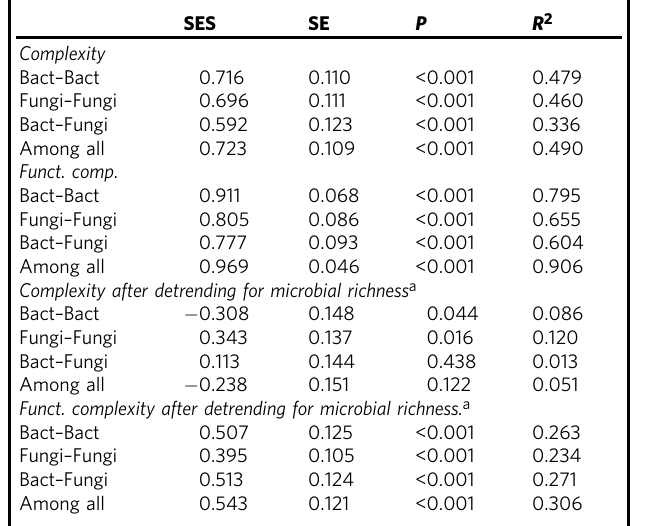
Table 2 The percent of variation ( % SS) in multifunctionality that is explained by each community